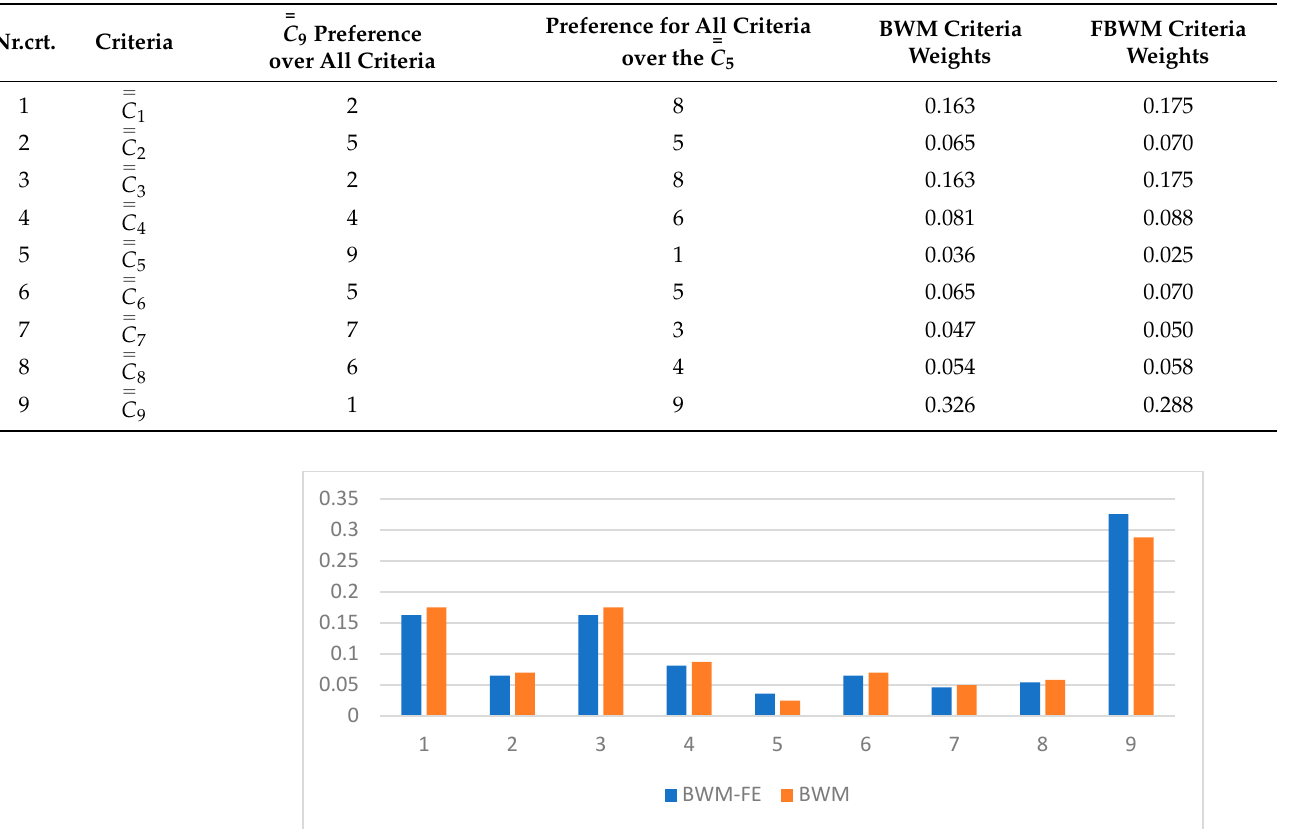
Table 6. Comparison between the vendors’ criteria weights obtained using BWM and FBWM.